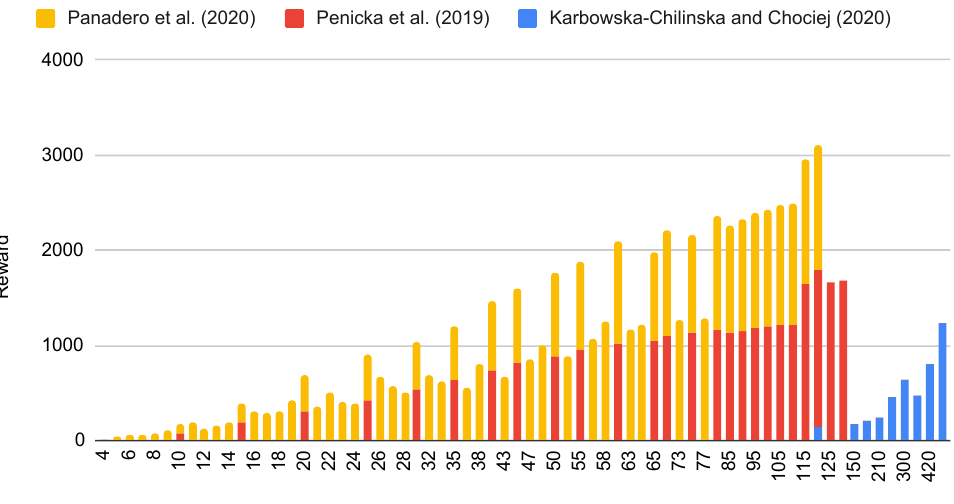
Figure 8. The expected reward (profit/benefit) according to the battery capacity of EVs.